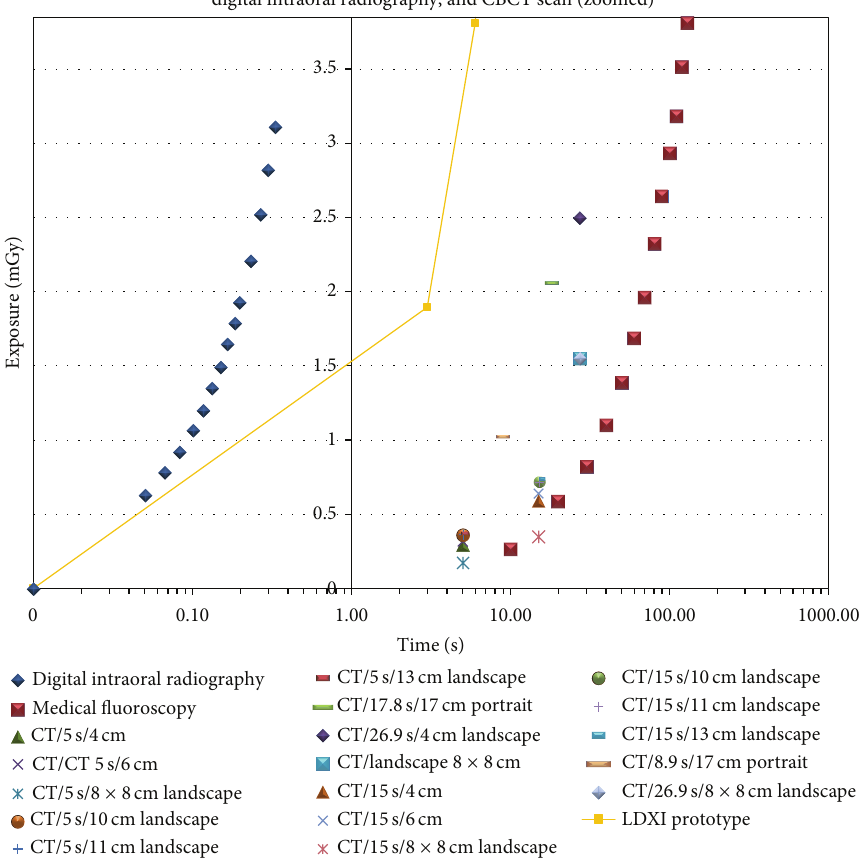
Figure 4: Radiation and timing exposures comparison amongst all